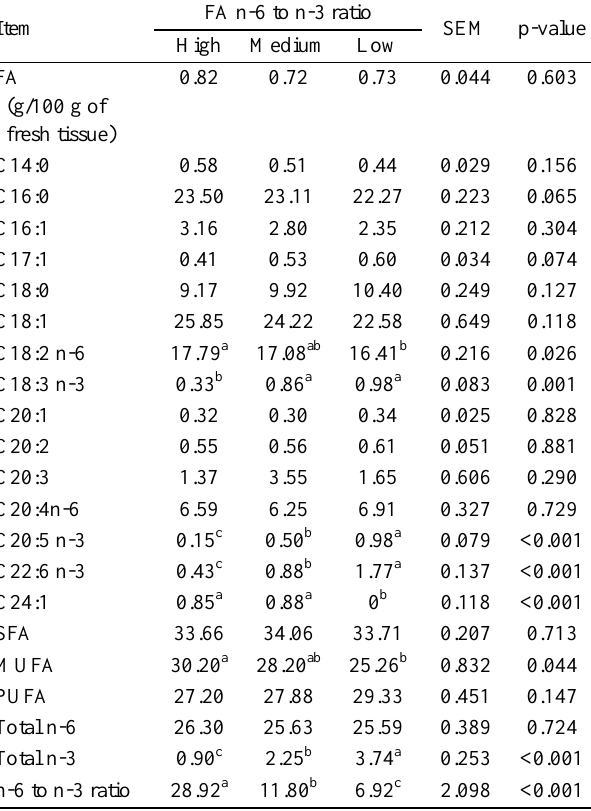
SEM, standard error of mean; SFA, saturated fatty acid; MUFA, mono- unsaturated fatty acid; PUFA, poly-unsaturated fatty acid. Means with different superscript letter differ significantly (p<0.05) among the